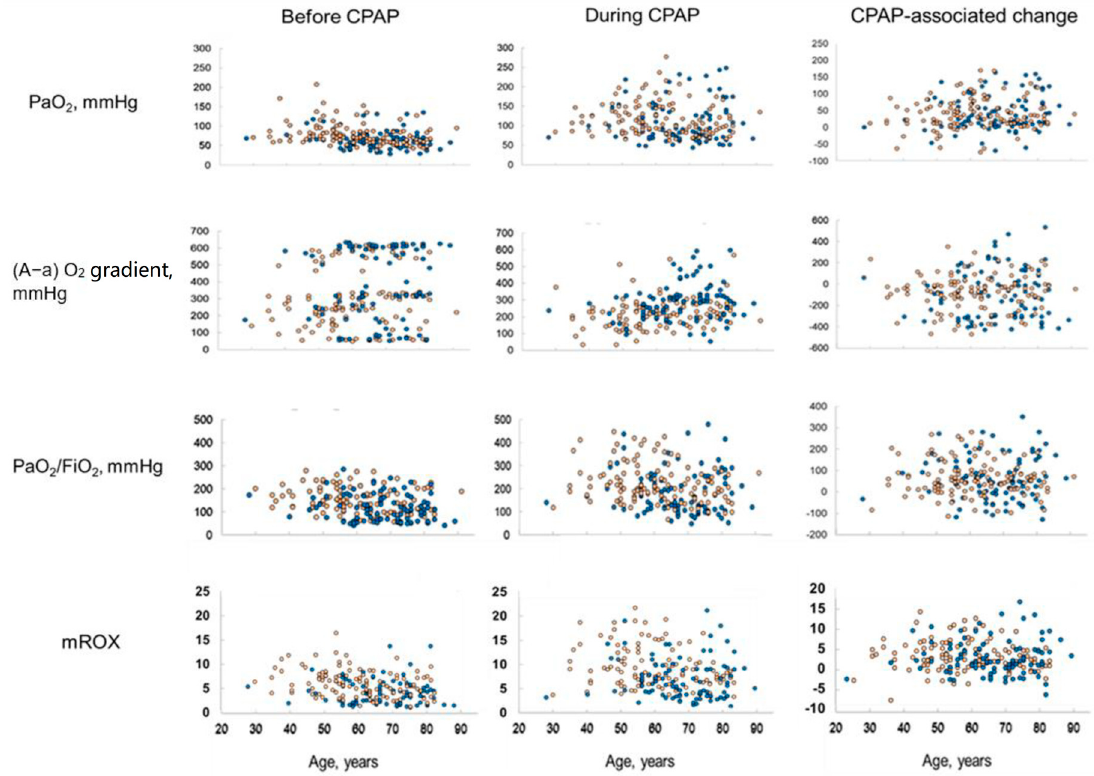
Figure 1. PaO 2 , (A-a) O 2 gradient, PaO 2 /FiO 2 ratio, and mROX before and during CPAP, and rel- ative differences. Physiological variables are plotted as a function of age to show their dispersed distribution in different patients. Orange circles = CPAP successes; Blue circles = CPAP failures; PaO 2 = arterial partial pressure of oxygen; CPAP = continuous positive airway pressure; mROX = PaO 2 /FiO 2 /respiratory rate; (A-a) O 2 gradient = alveolar-arterial oxygen gradient; FiO 2 = fraction of inspired